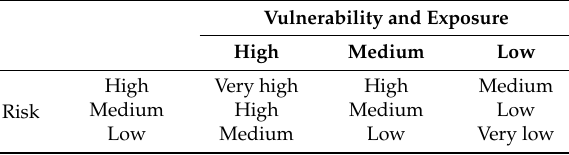
Table 4. Impact matrix.